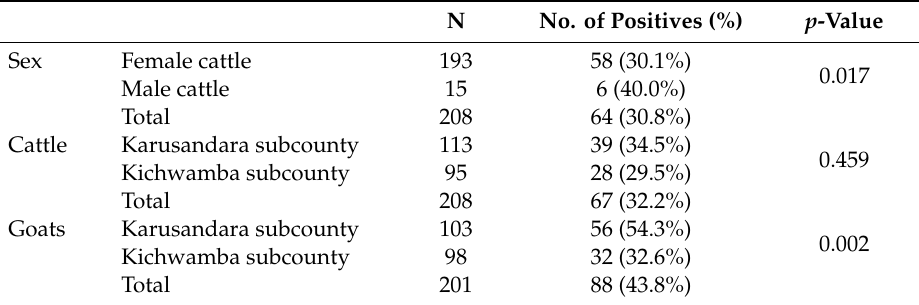
Table 3. Hemoplasma detection rates based on sex and location.